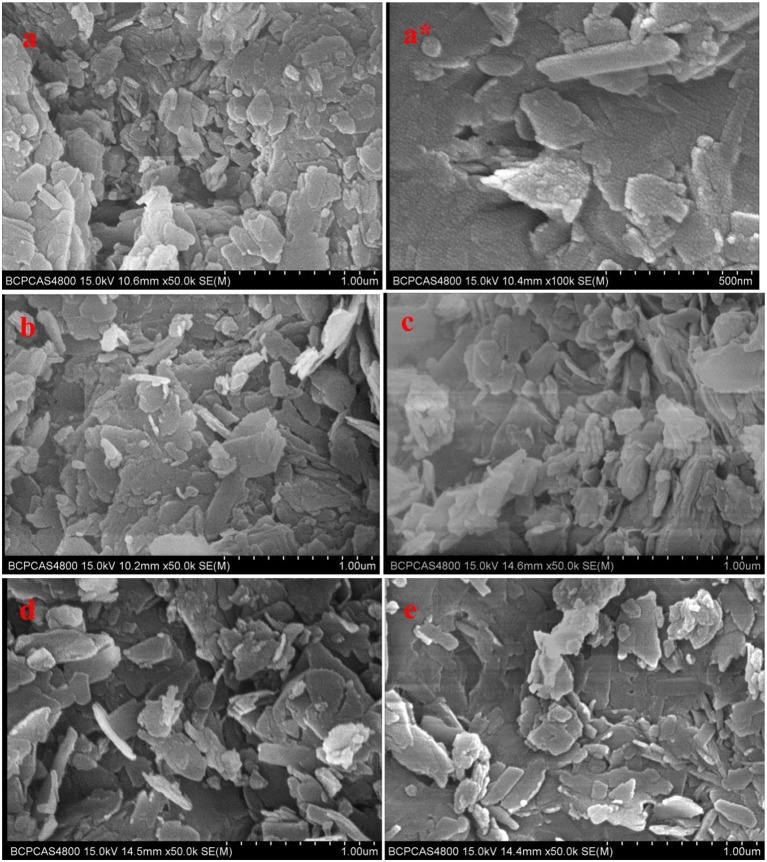
SEM photographs of clinoptilolites: (a,a*). C-0, (b). C-1, (c). C-2, (d). C-3, (e). C-4.